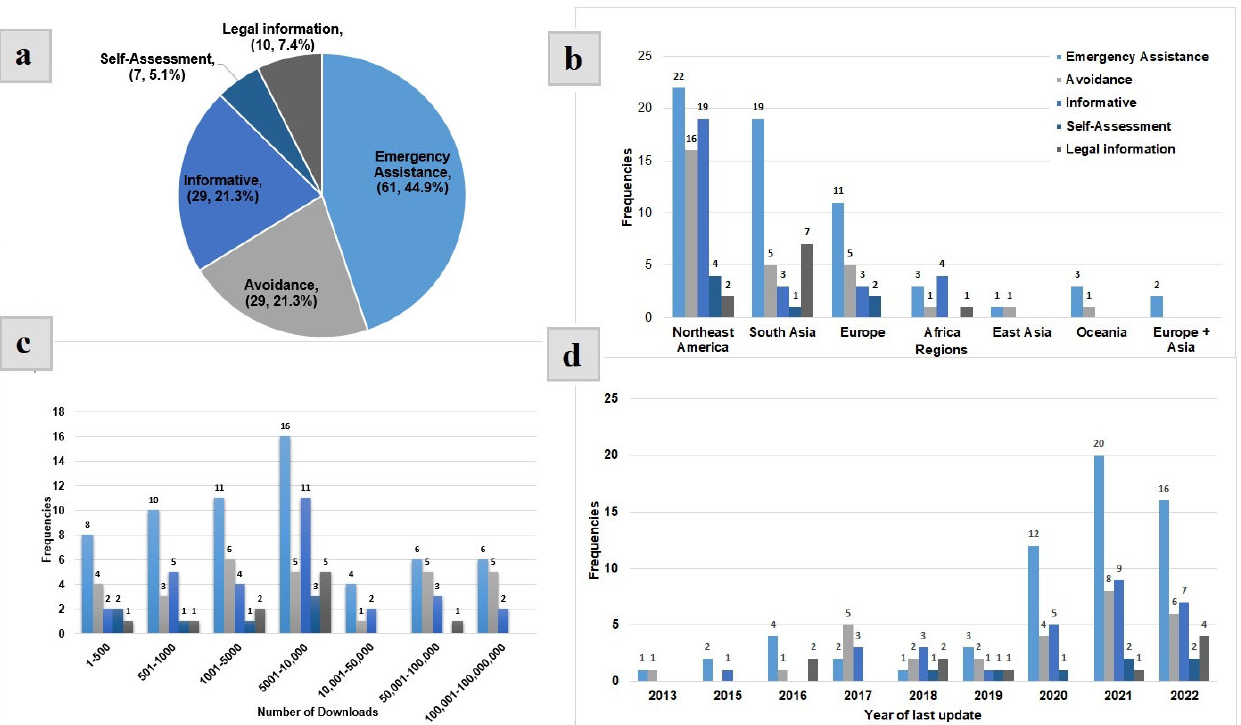
Figure 2. Distribution of 136 apps: ( a ) five functional categories (data presented as number and percentage), ( b ) region, ( c ) number of downloads, and ( d ) year of last update.